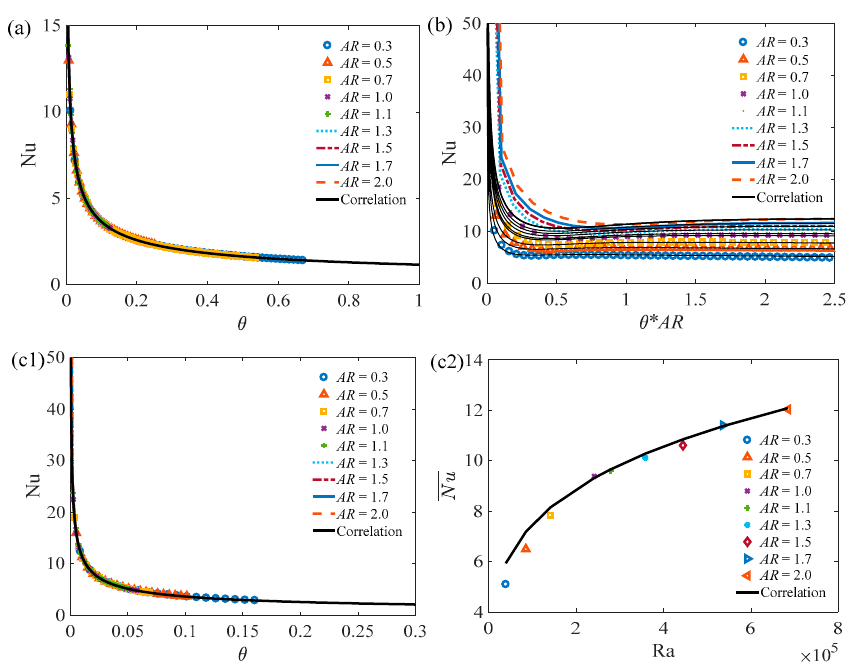
Figure 15. Unified results for the Nusselt number of PCM in rectangular enclosures with different aspect ratios. ( a ) Heating the top side; ( b ) heating the right side; ( c1 ) heating the bottom side ( θ ≤ θ c ); ( c2 ) heating the bottom side ( θ > θ c ).